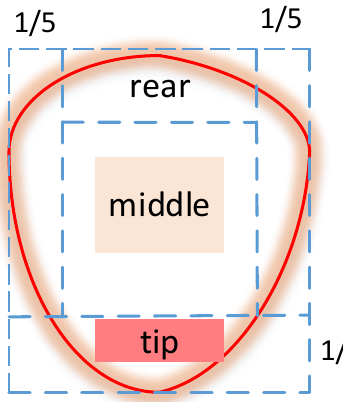
Figure 8. Five divisions of the human tongue.